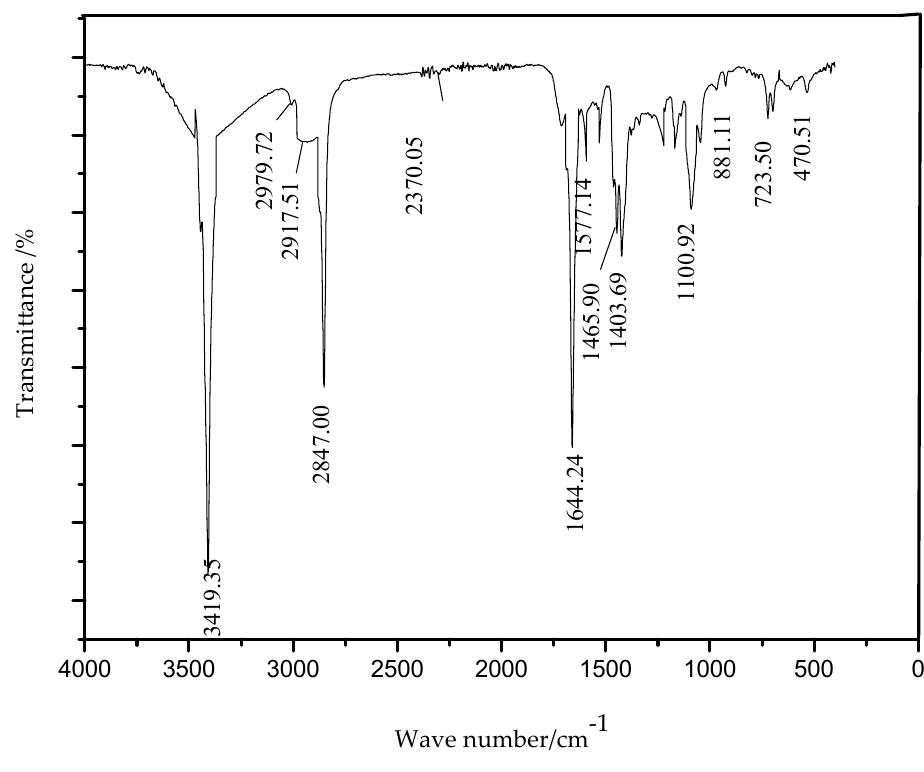
Figure 12. Infrared spectrum of toluenesulfonamide(ST).